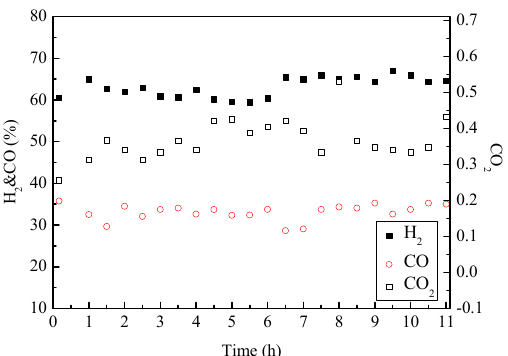
Figure 6. Syngas composition as a function of time (temperature: 400 ◦ C, plate position: 15 mm, superficial gas velocity: 2.95 mm /